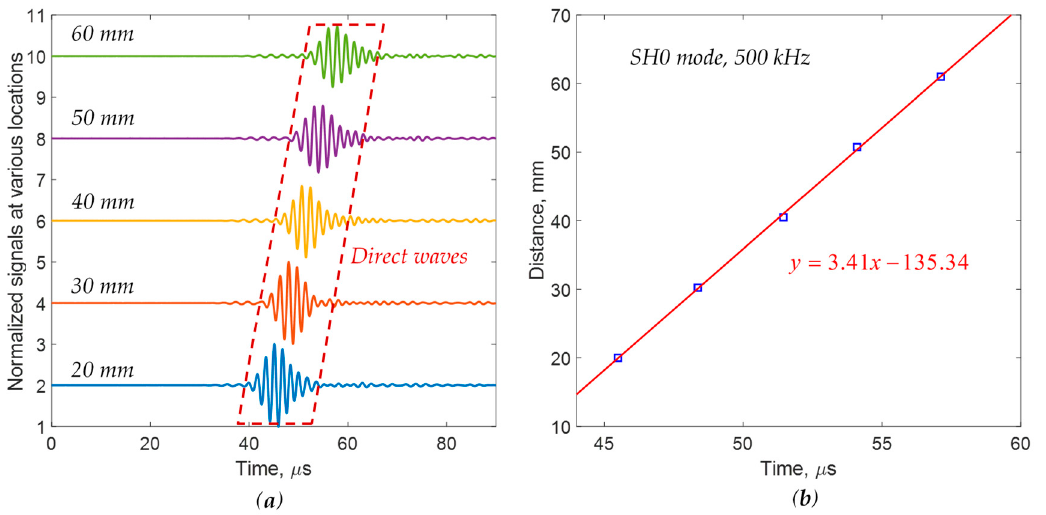
Figure 11. Experimental group velocity measurement for the SH0 mode excitation: ( a ) waveforms at various locations; ( b ) correlation between distance and time of flight for the group velocity calculation.